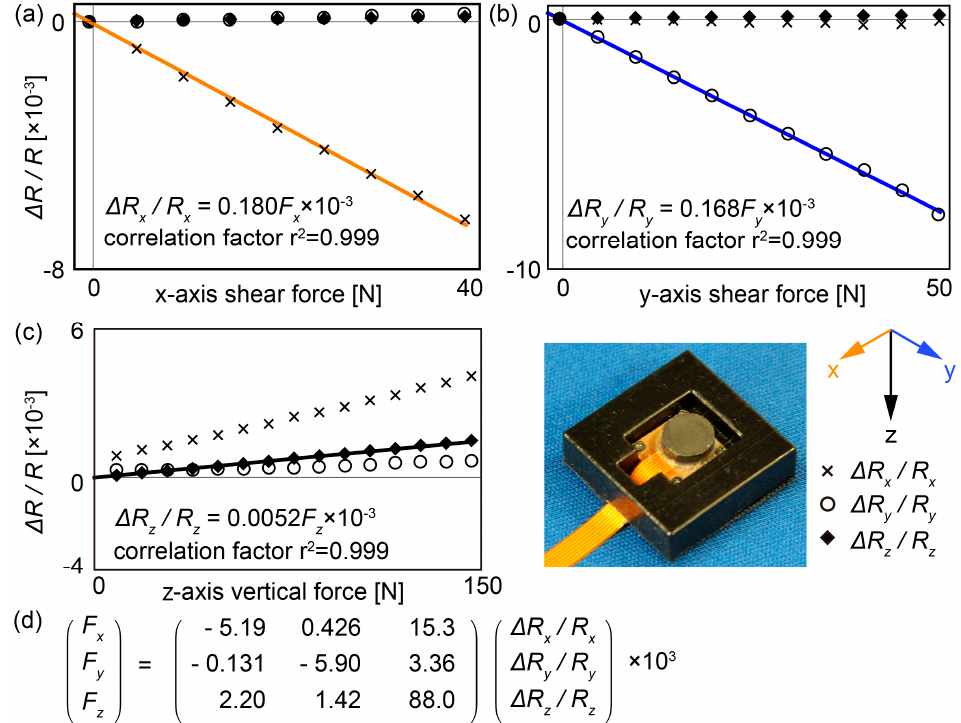
Figure 2. Outputs of the three-axis force sensor embedded in rubber material used as a sole. ( a ), ( b ) and ( c ) are the results when x-, y- and z-axis force were applied to the sensor, respectively. The markers in the graphs are plotted on the measured values. The solid lines in the graphs are fitting values obtained using the least-squares technique. ( d ) Equation of a force sensor to convert from resistivity changes to forces.